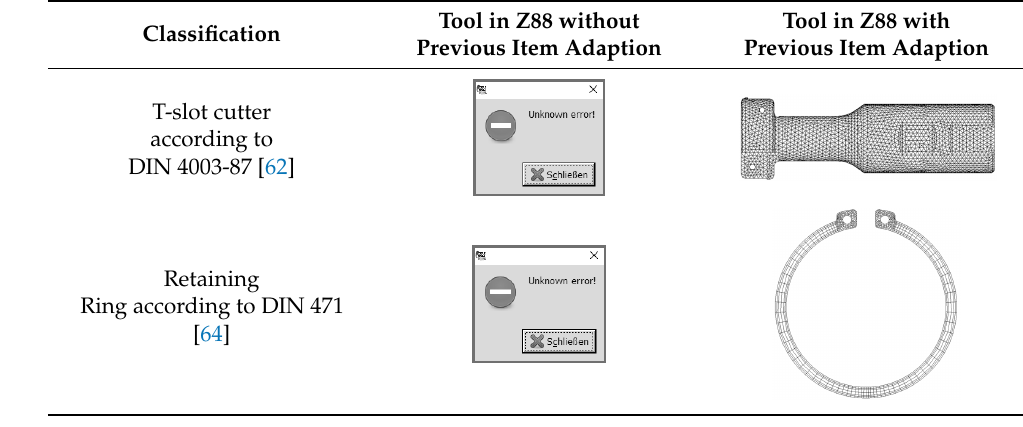
Table 4. Demonstration of item adaption using the example of meshed parts.